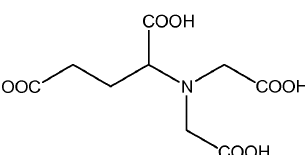
Figure 1. Glutamic acid, N, N-diacetic acid (GLDA) chemical structure, the acid form was used in this paper at pH 3.8.